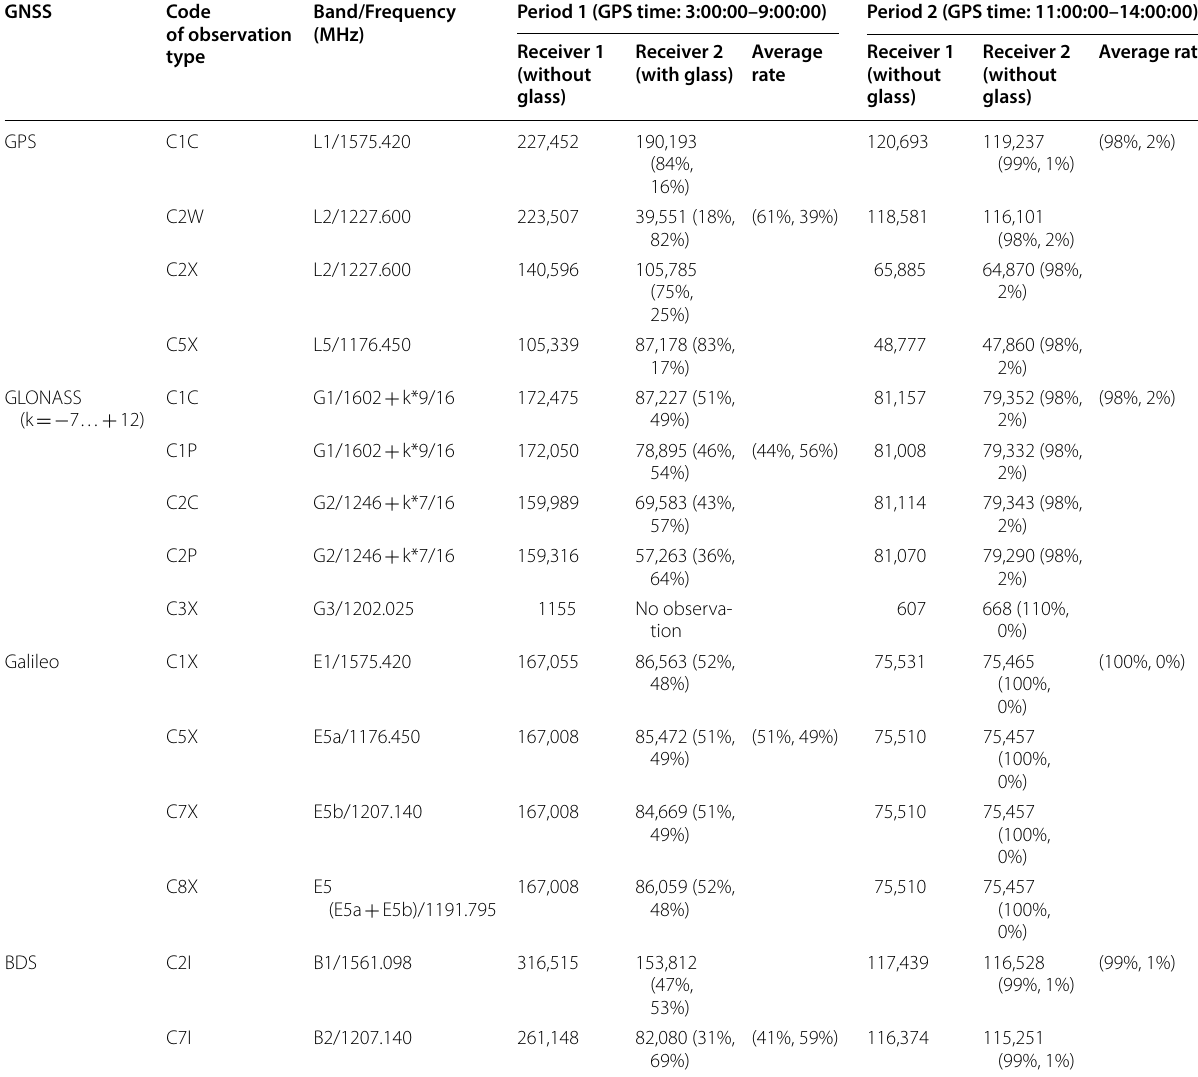
In each pair of parentheses, the first number denotes the percentage of observations of receiver 2 with respect to receiver 1 and the second number denotes the percentage of data loss of receiver 2